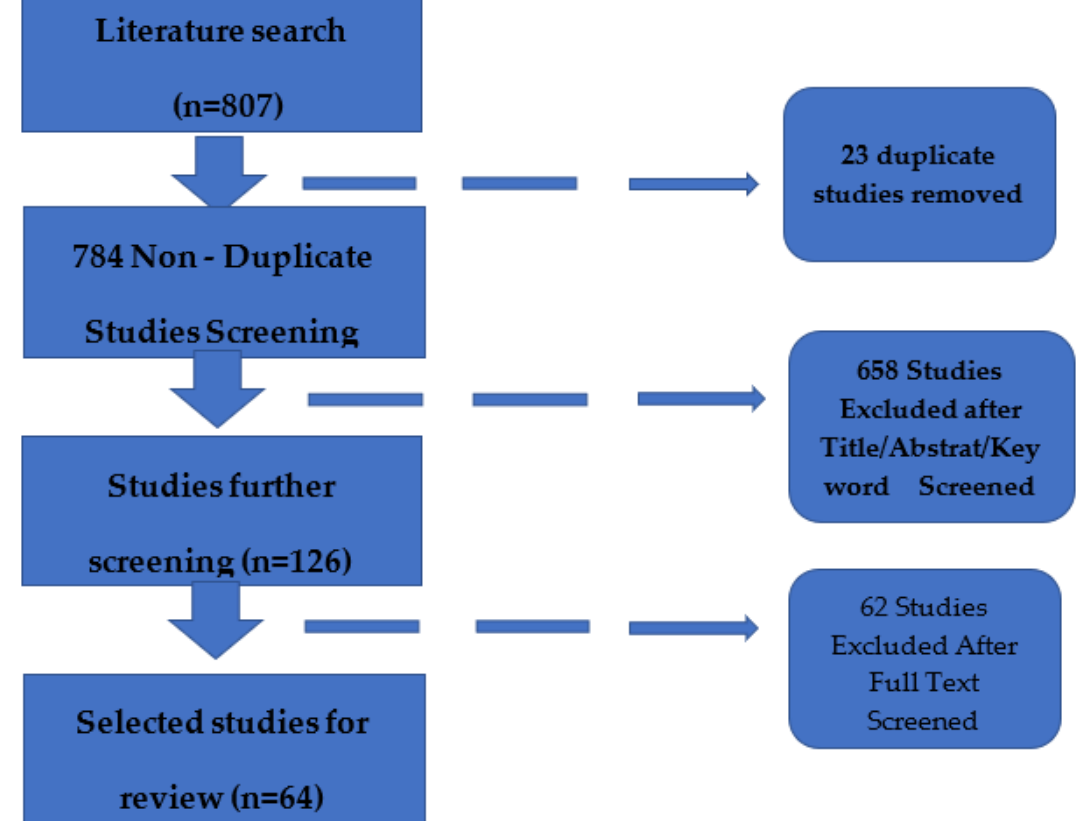
Figure 1. The PRISMA flowchart used in this review.